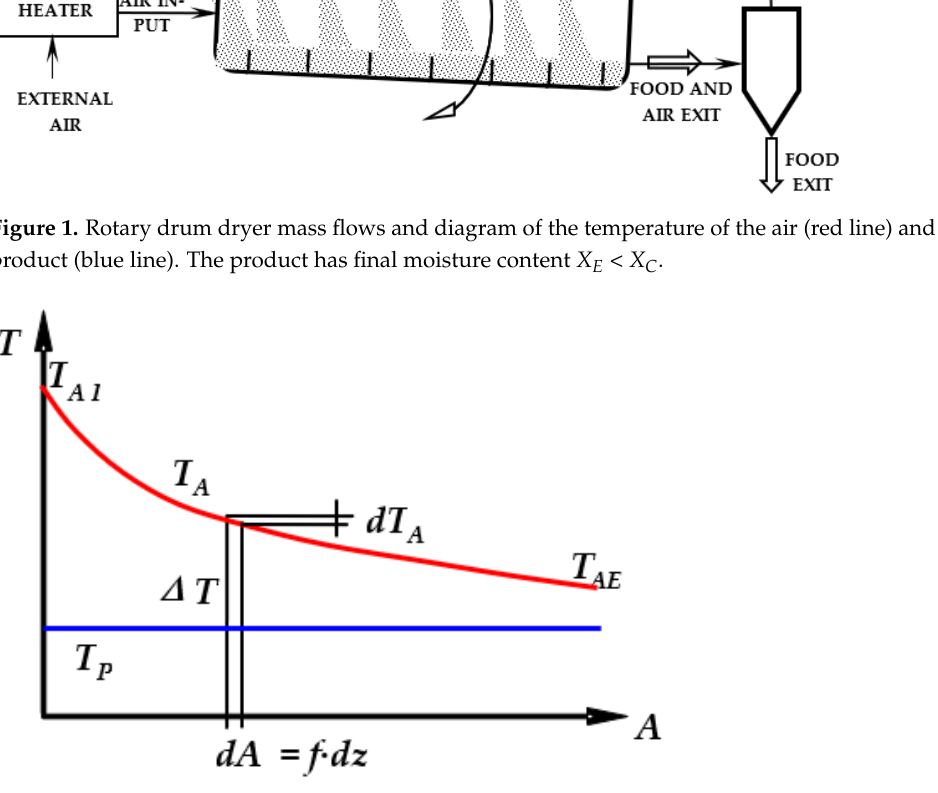
Figure 1. Rotary drum dryer mass flows and diagram of the temperature of the air (red line) and the product (blue line). The product has final moisture content X E < X C .